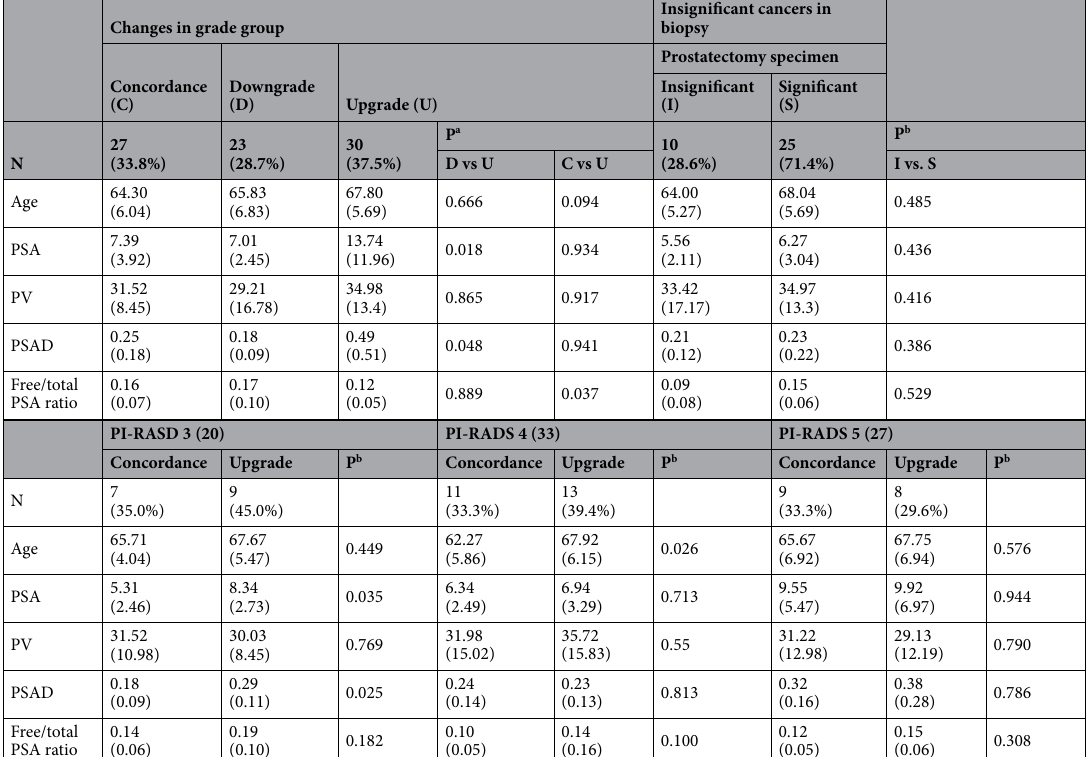
Table 3. Comparison of clinical parameters according to changes in the grade group. a One-way